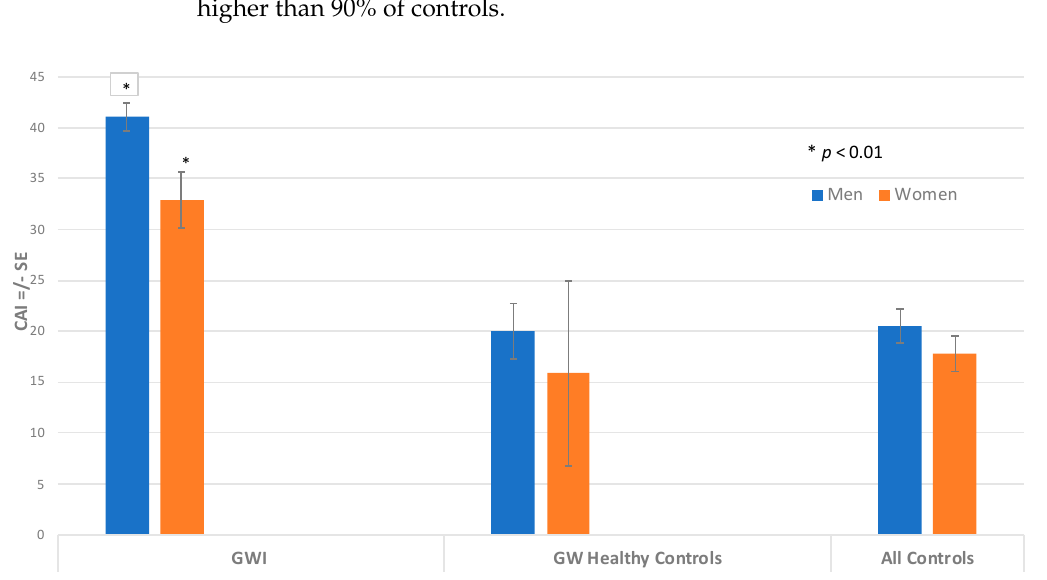
Figure 3. CNS Autoantibody Index (CAI) for Men and Women. Comparing CAI for men and women using ANCOVA, adjusting for age and race. The height of the bar denotes adjusted mean CAI +/ − standard error. CAI for GWI is significantly different than CAI for GWI women (* p < 0.01).